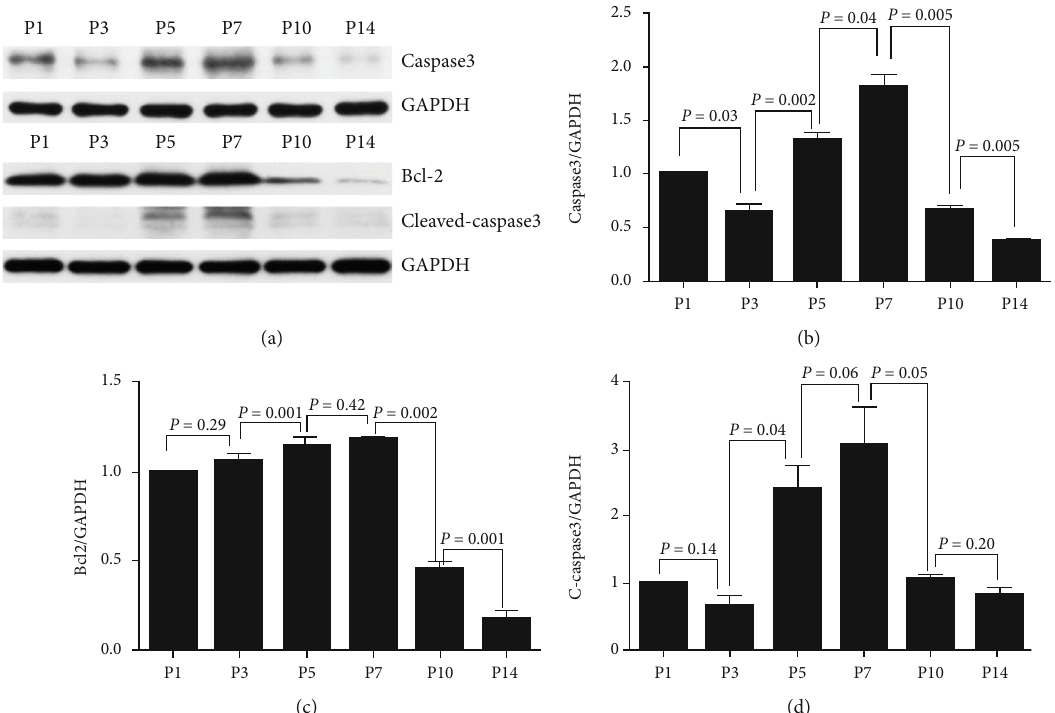
Figure 5: Western blot quantitative analysis for dynamic changes in apoptosis-associated proteins in SGN. (a) The protein expression levels of Bcl2, caspase3, cleaved-caspase3, and GAPDH were measured by western blotting at di ff erent developmental time points. (b), (c), and (d) show the half quantitative analysis of Bcl2, caspase3, and cleaved-caspase3 expressions, respectively; and it was normalized to that of GAPDH expression levels. Signi fi cant di ff erences were evaluated using repeated measures